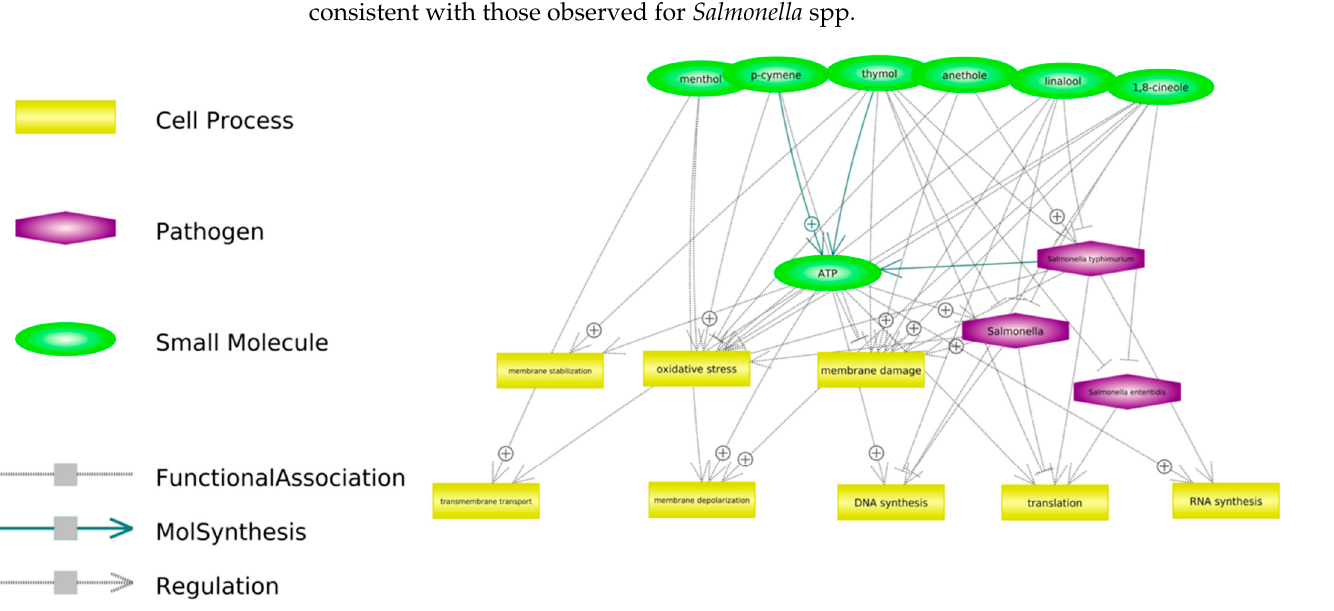
Table 3. MIC of analyzed mixture.